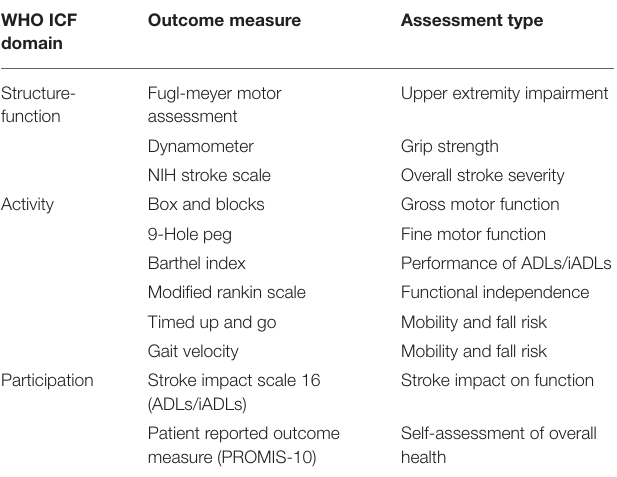
TABLE 1 | Outcome measures administered in MGH Stroke Motor Rehabilitation and Recovery Study (SMaHRT) spanning International Classification of Functioning